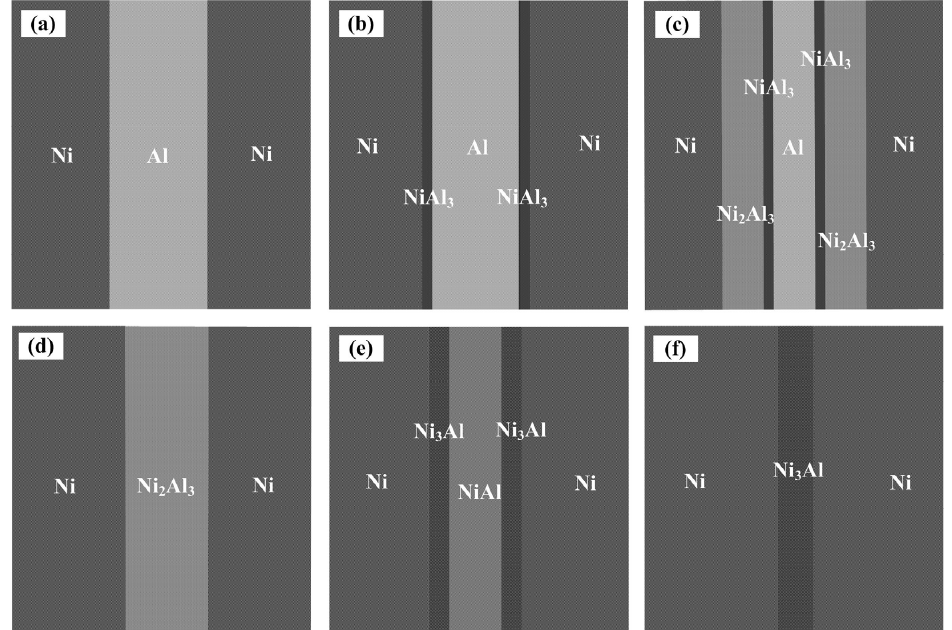
Figure 11. Schematic illustration of the reaction synthesis mechanism of the laminated composites. ( a ) The hot-pressed Ni/Al/Ni laminated composites; ( b ) NiAl 3 layers are formed between Ni and Al layers; ( c ) Ni 2 Al 3 layers are formed between NiAl 3 and Ni layers; ( d ) NiAl 3 disappears and forms the Ni/Ni 2 Al 3 /Ni lamellar structure; ( e ) Ni 3 Al layers are formed between NiAl and Ni layers; ( f ) NiAl disappears and forms the Ni/Ni 3 Al/Ni lamellar structure.